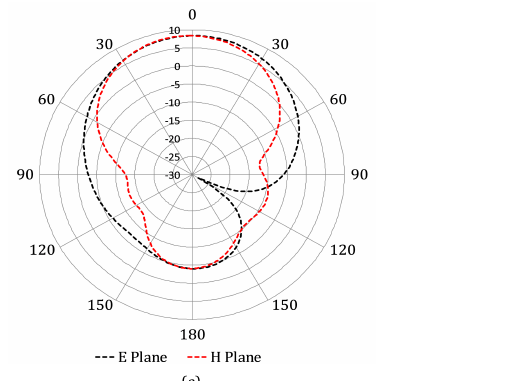
Figure 10. VSWR of conventional dual band antenna.